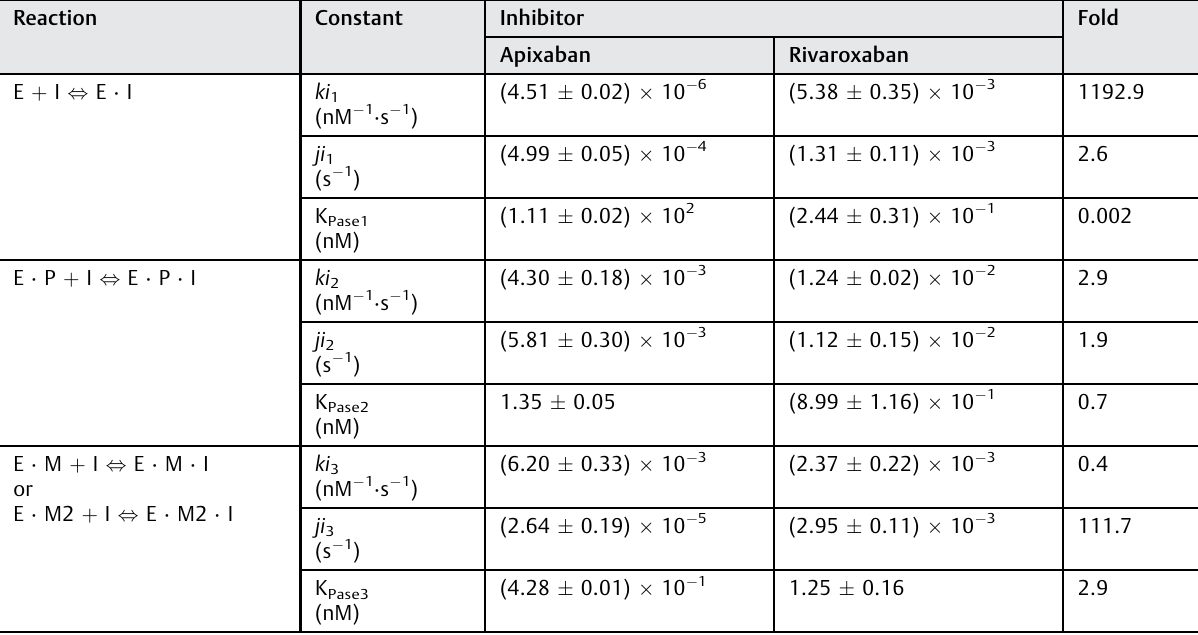
Table 2 Kinetic parameters of inhibition of factor Xa incorporated in prothrombinase by apixaban or rivaroxaban as measured using thrombin-DAPA fl uorescence Reaction